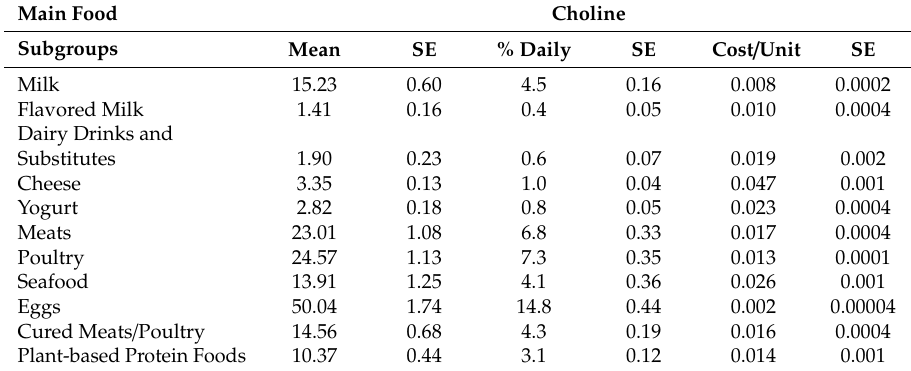
Table 10. Percent daily choline (mg) and cost ($) of choline from eggs in adults compared to USDA protein food subgroups.